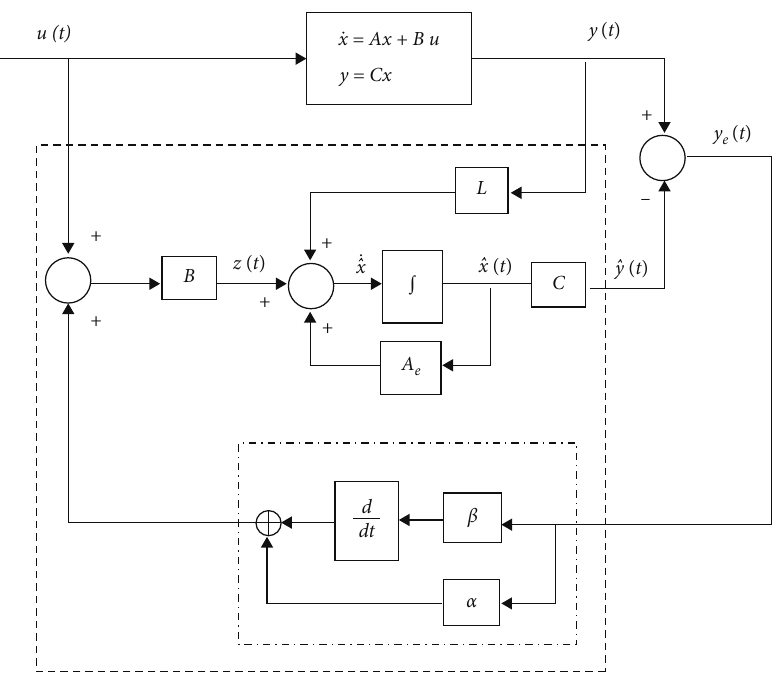
Figure 3: A structure of state observer with PD